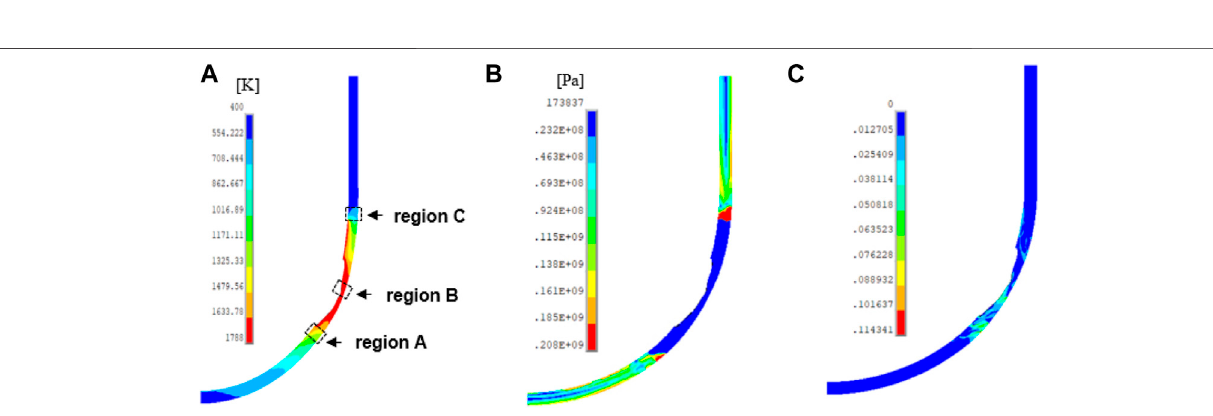
FIGURE 9 | (A) Temperature distribution (K), (B) von Mises stress distribution (Pa), and (C) creep strain distribution of the vessel wall at time = 7.16 h for the SBO case.